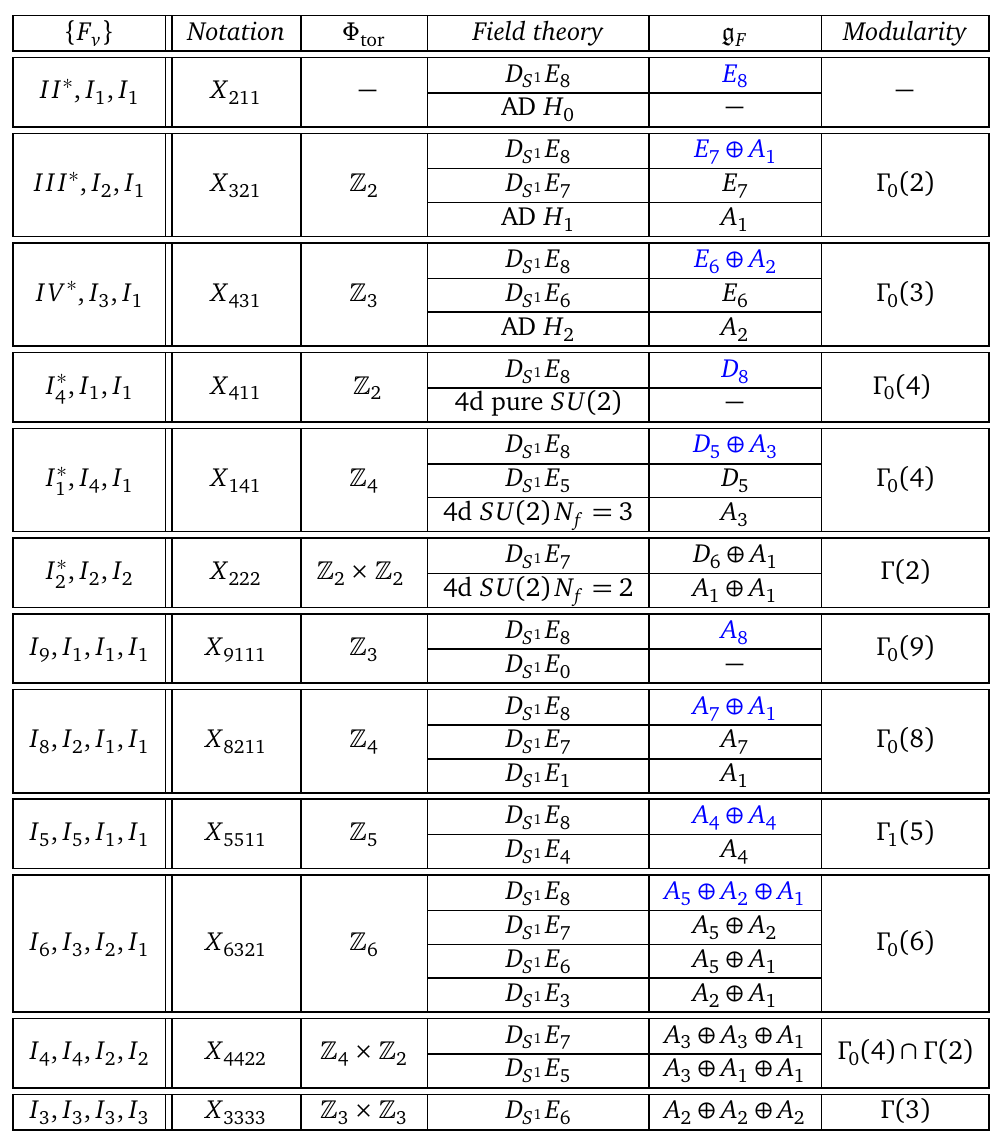
fibers and corresponding field k